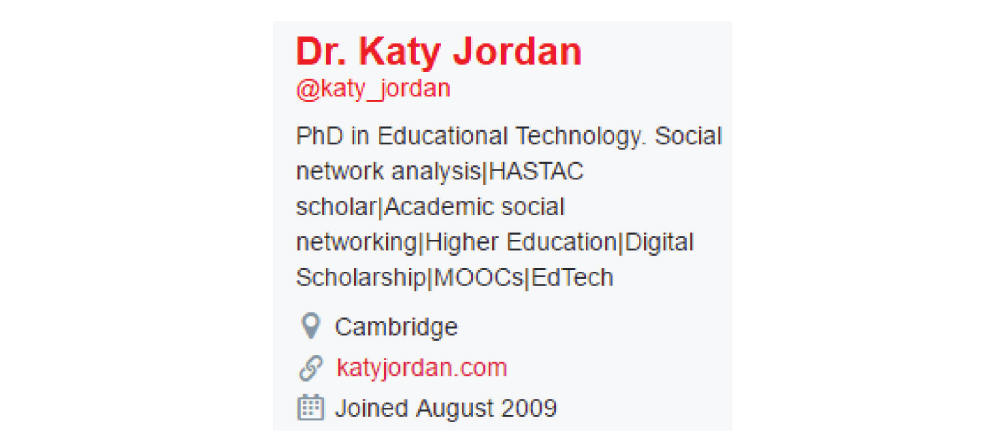
Figure 3: Example of Twitter